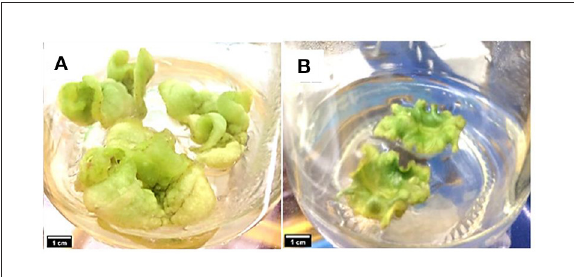
FIGURE1 Callus induction and development observed on (A) MS medium supplemented with 0.6 mg/L of TDZ (CM media), and (B) MS medium without PGR (MSO) after 8